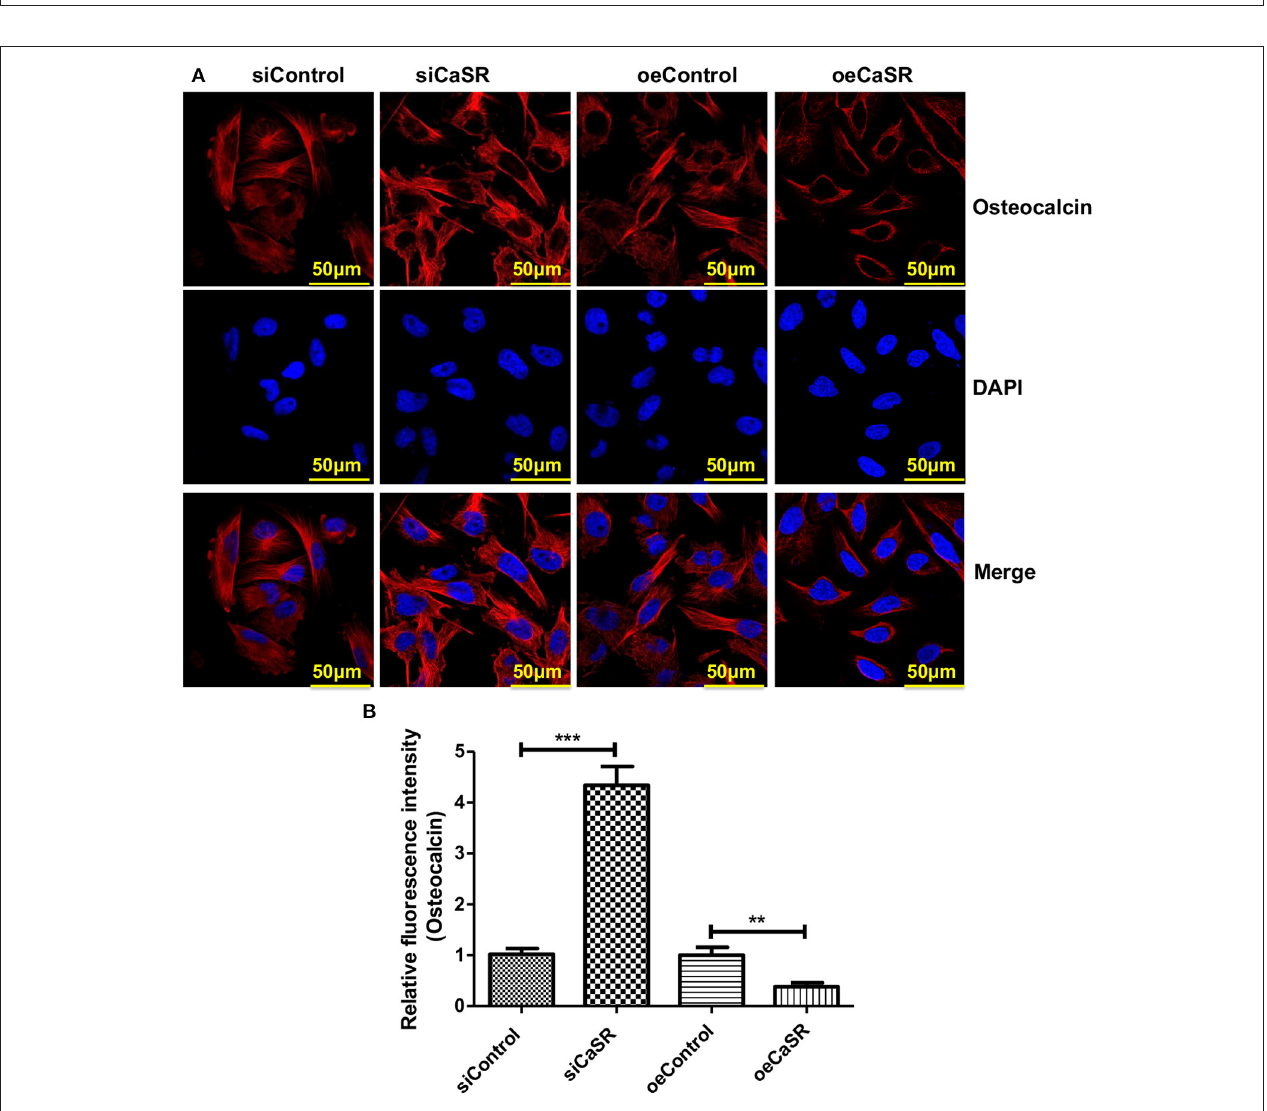
FIGURE 5 | AS-stained OB area was calculated using ImageJ software (NIH). The number of OBs in CaSR overexpression group was significantly lower than that in empty vector and negative control groups ( p < 0.001). There was no significant difference between empty vector and negative control groups ( p > 0.05). Osteogenic area in CaSR overexpression group was significantly smaller than that in empty vector and negative control groups ( p < 0.001). While there was a difference between negative and empty vector control groups, this difference was not statistically significant ( p > 0.05). OB number and osteogenic area size were significantly higher in CaSR knockdown group than in empty vector and negative control groups ( p < 0.001). (E) OB expression induced OC maturation and differentiation enzymes RANKL, M-CSF, and OPG were detected using western blots. ImageJ software (NIH) for image processing was used to verify band intensities as a result of semi-quantitative western blotting. RANKL and M-CSF protein expression was significantly higher in CaSR overexpression group than in empty vector control group. OPG protein expression level was significantly lower in CaSR overexpression group than in empty vector and negative control groups ( p < 0.001). * p < 0.05, ** p < 0.01, *** p < 0.001.